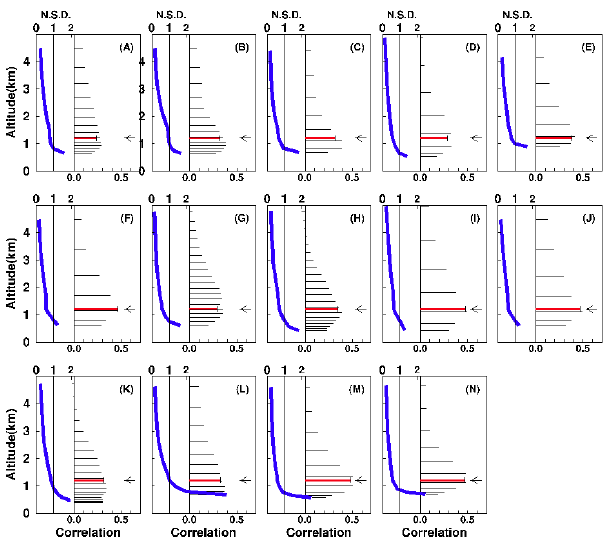
Fig. 5. Vertical profile of normalized standard deviation (N.S.D.) and correlation of simulated to measured concentrations at Schauinsland. Each panel corresponds to a model listed in Table 1. In each panel, N.S.Ds are plotted on the left side (blue). Correla- tions between simulated and measured concentrations are shown in the right hand side of a panel. Altitude of Schauinsland is indicated by an arrow in each panel. Correlations at the altitude is indicated with the red bar.